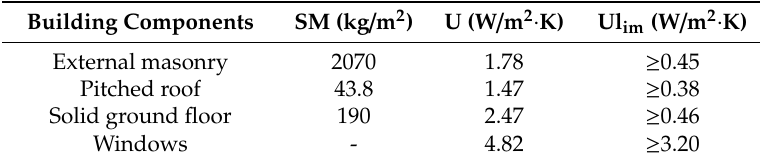
Table 2. Thermal transmittance and surface density of the building components.